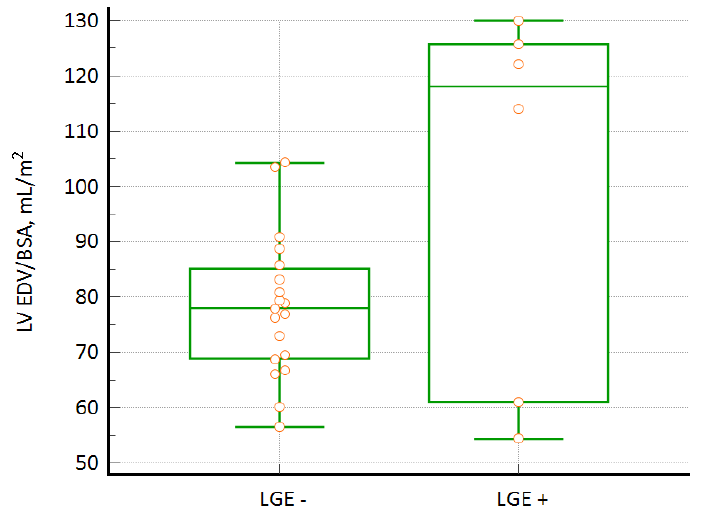
Figure 2. LV EDV/BSA comparison between LVNC patients with and without